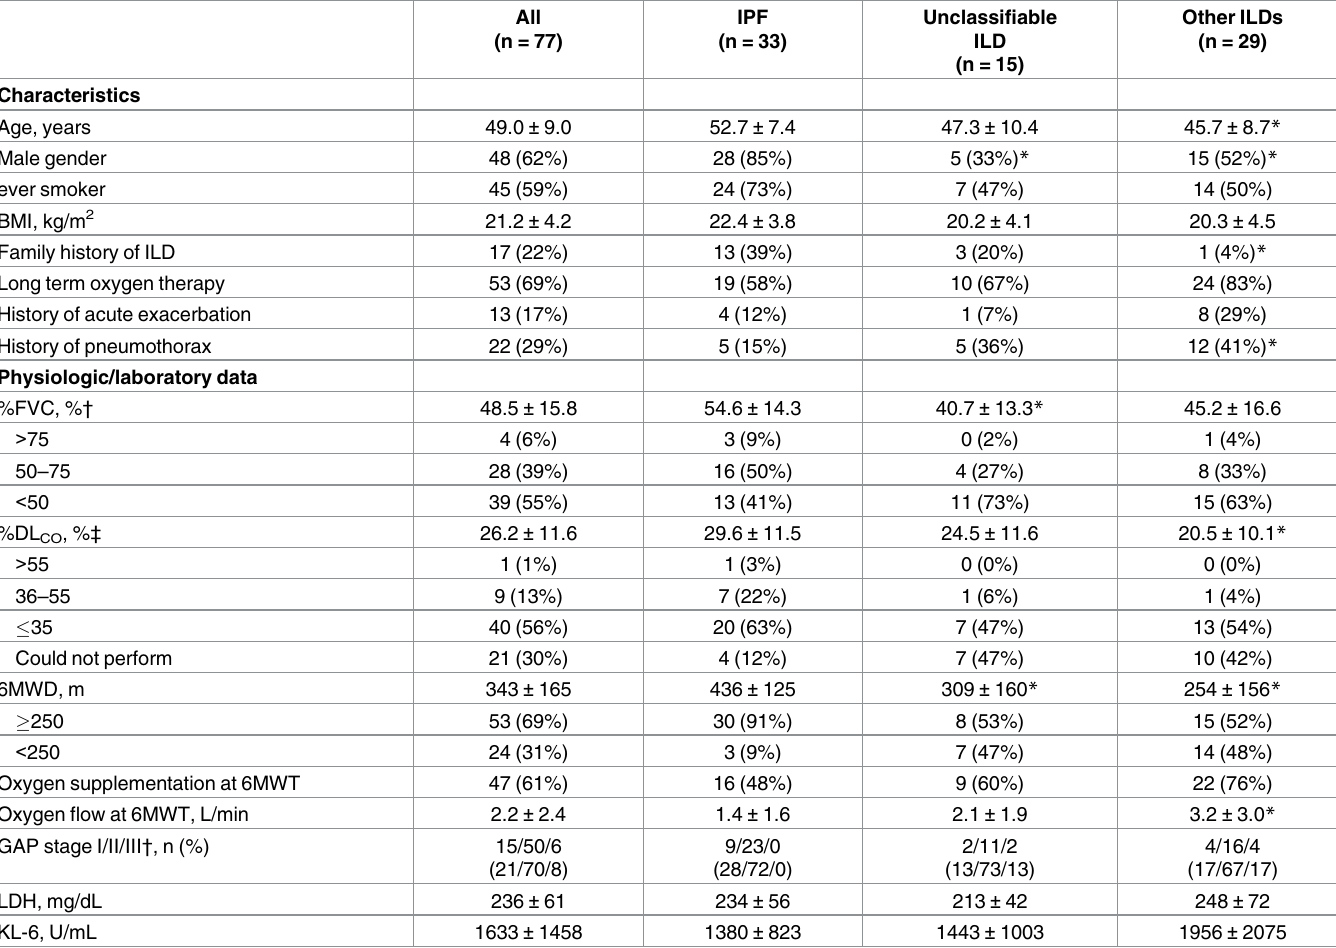
Table 2. Characteristics/Physiologic and laboratory data of lung transplantation candidates with interstitial lung disease (n = 77).